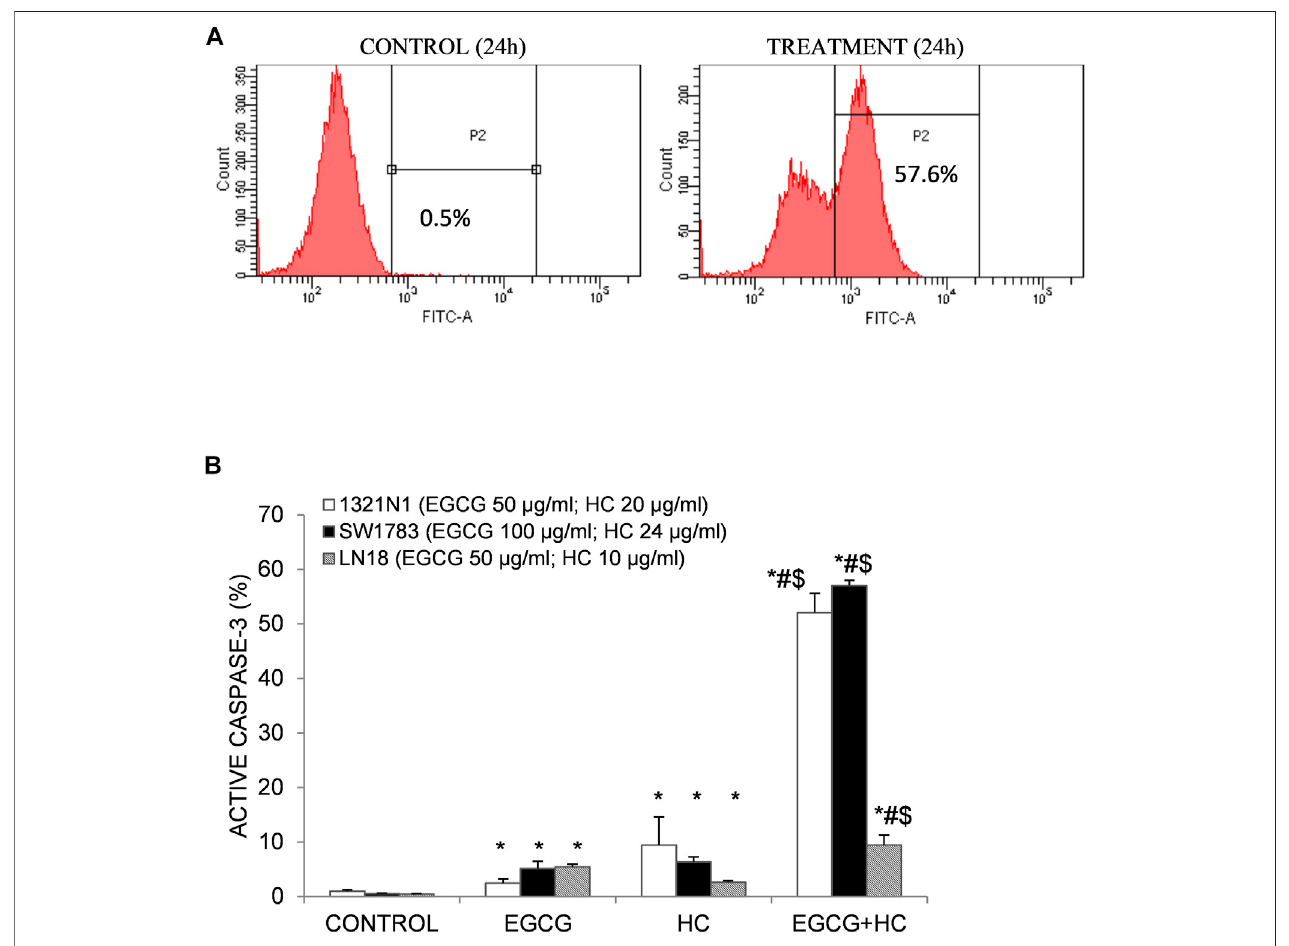
FIGURE3|(A) Flowcytometrydetectionofapoptosisfollowingcaspase-3antibodystaining.Anexampleofanactivecaspase-3detectiondiagramusing1321N1 cells: viable cells are indicated in the left quadrant, while active caspase-3 is displayed in the right quadrant (P2). (B) As evidenced by the presence of active caspase-3, combined EGCG+HC triggered stronger induction of apoptosis in 1321N1, SW1783, and LN18 cells than either EGCG/HC alone. Data represents mean±SD of three independent experiments. * p < 0.05 compare to vehicle control, # p < 0.05 compare to EGCG, $ p < 0.05 compare to